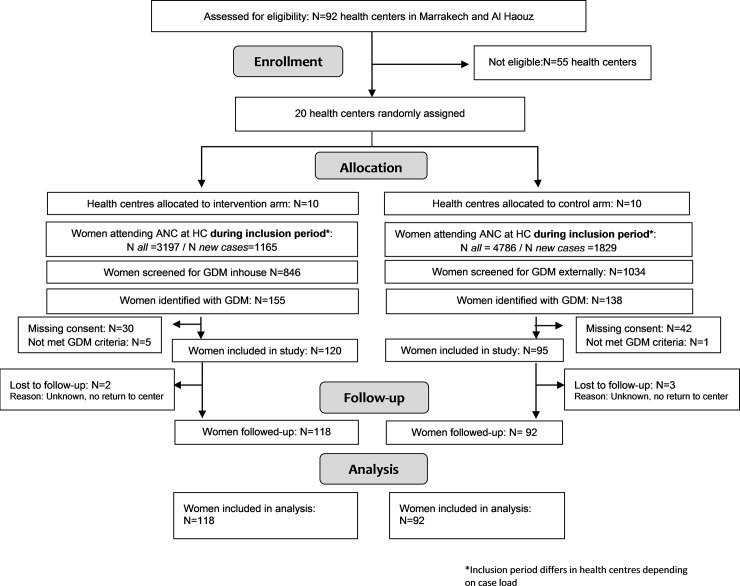
Consort trial flow chart.